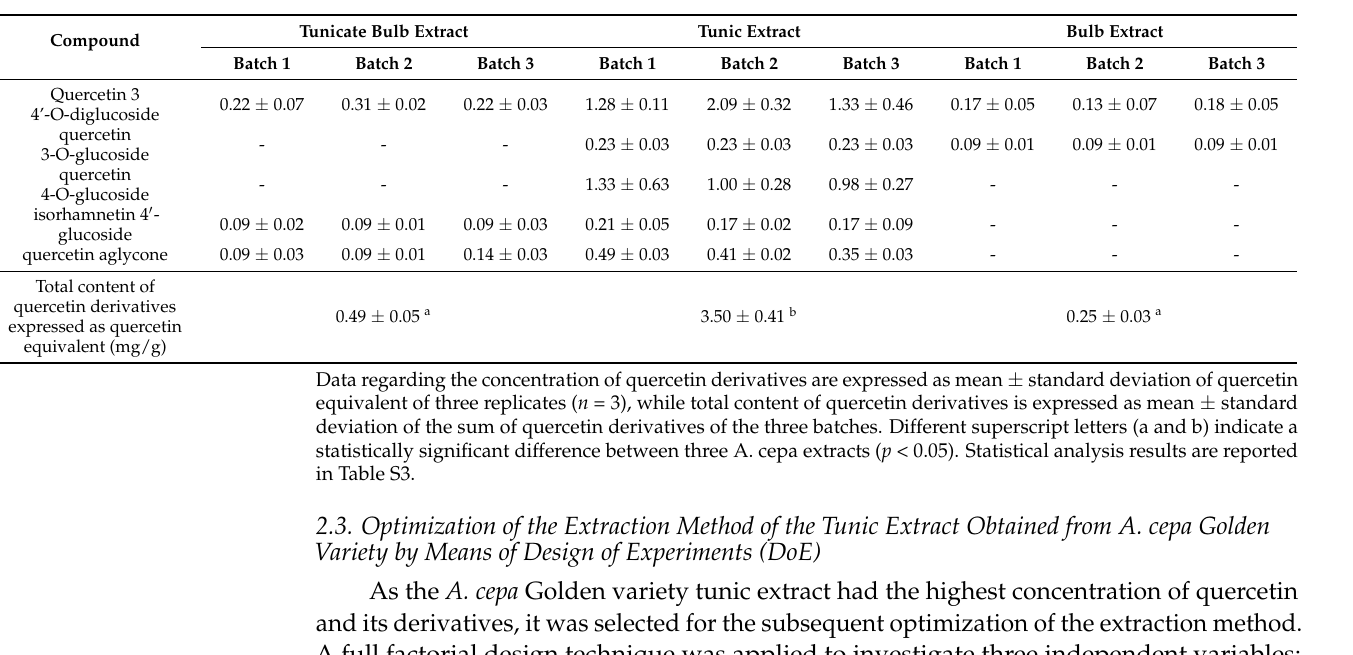
Table 3. Concentrations of quercetin derivatives (expressed as mg of quercetin aglycone/g of extract) in three different batches (batch 1, 2, and 3) of A. cepa Golden variety bulb, tunicate bulb, and tunic extracts and mean of the total content of quercetin derivatives expressed as quercetin